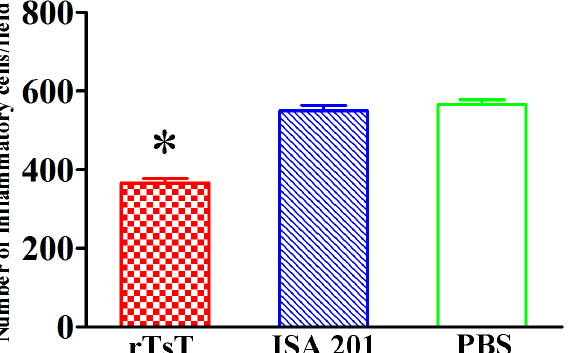
and PBS groups. Scale-bars: 100 µm.